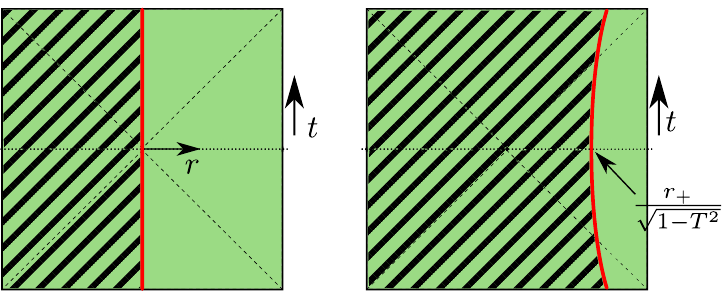
Figure 4 . Left: Zero tension ETW brane. The solution can be thought of as a Z 2 orbifold of the original eternal black hole solution. Right: Negative tension ETW brane. From the right exterior this solution looks like a brane which emerges from the white hole and falls into the black